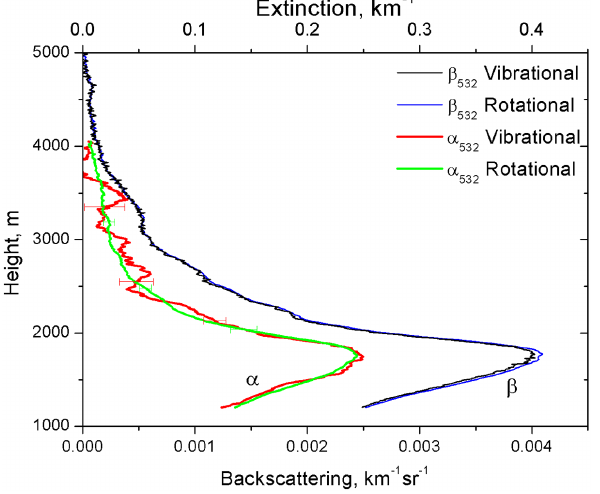
Figure 10. Vertical profiles of 3 β + 2 α measurements on 1 July 2014. Extinction coefficient at 532nm is calculated from RR sig-